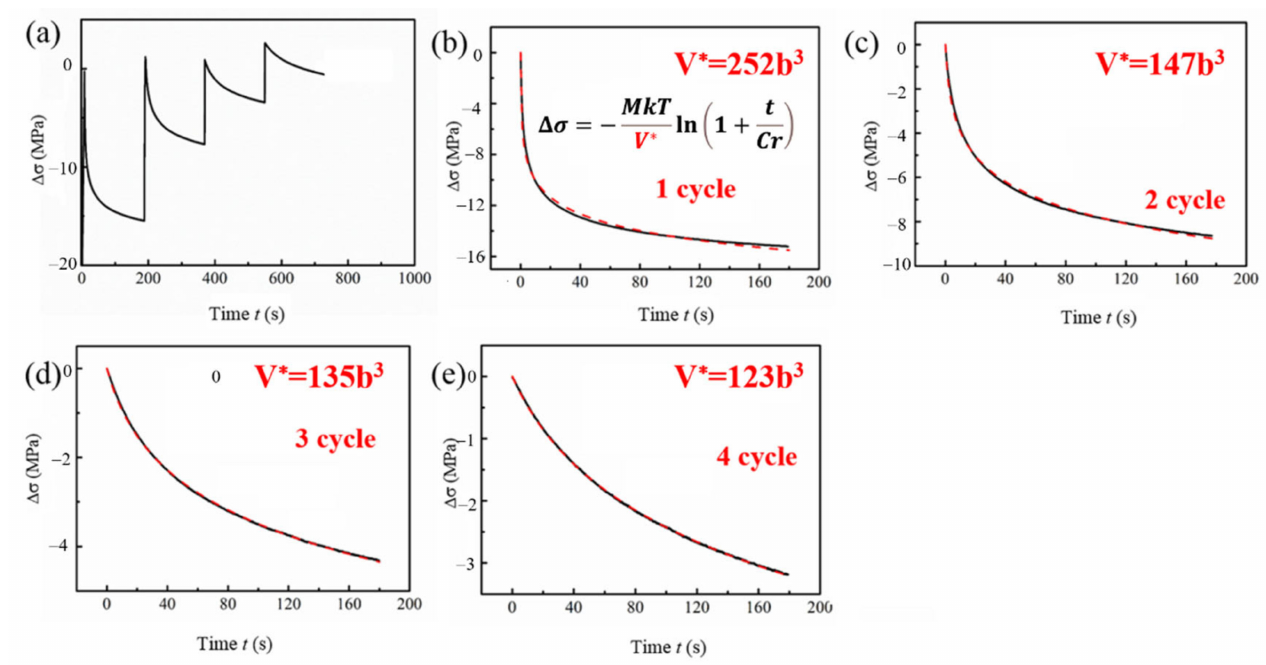
Figure 5. Fitting of the experimental data of each cycle during the conventional stress relaxation test, ( a ) 4 cycles; ( b ) first cycle; ( c ) second cycle; ( d ) third cycle; ( e ) fourth